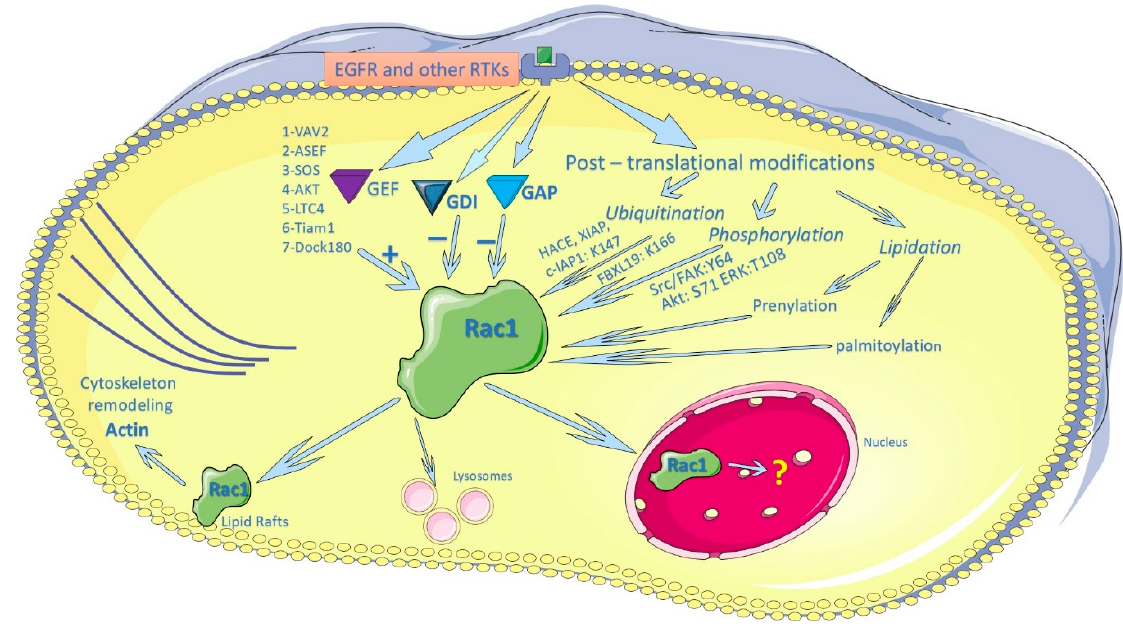
Figure 3. Summary of Rac1 regulation, subcellular distribution, and function.